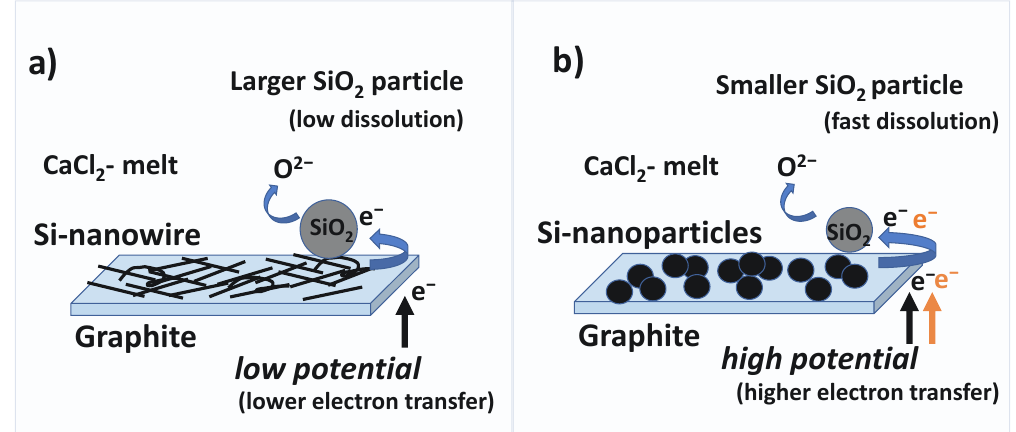
Figure 6. Schematic diagram of the Si growth mechanism on graphite substrates. ( a ) Favorable conditions for the formation of Si-nanowires, ( b ) favorable conditions for the formation of Si-nanoparticles. As apparent from the schematic diagram, for a given substrate material, both